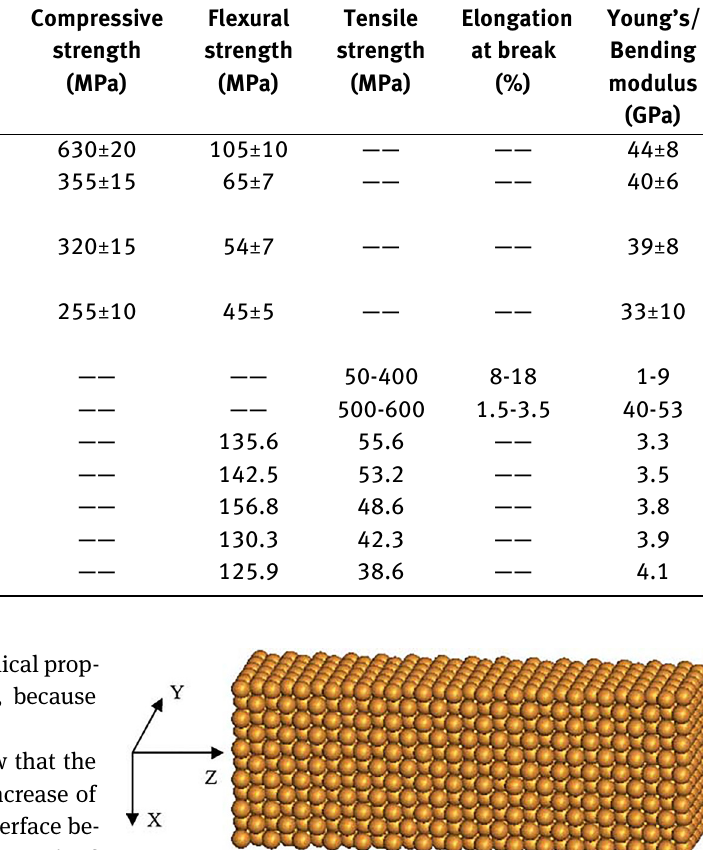
uli of complex multilayer nano-interconnects and corrob- orated it with the finite element